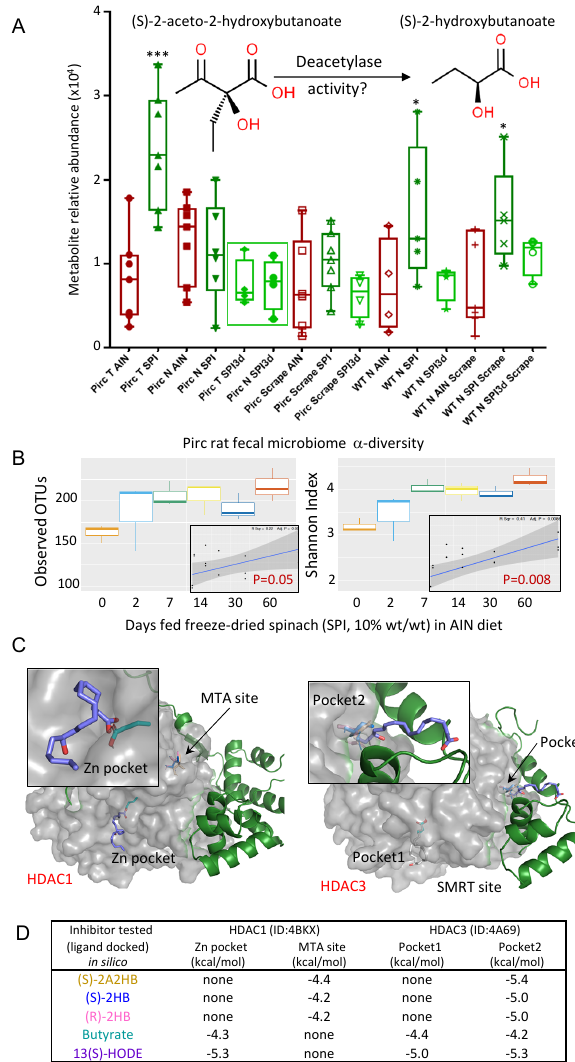
Figure 5. Butanoate metabolites exhibit favorable HDAC interactions. ( A ) Relative abundance of